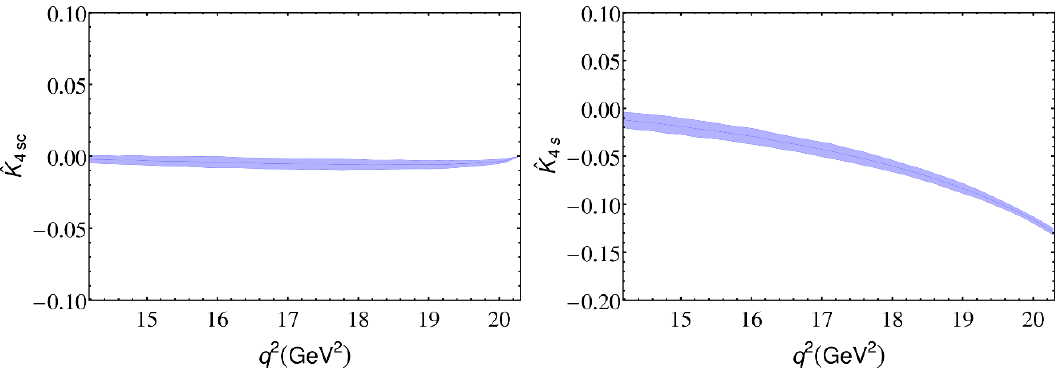
Figure 2 . The SM predictions of ^ K 4 sc and ^ K 4 s for (cid:3) b ! (cid:3)( ! p + (cid:25) (cid:0) ) (cid:28) + (cid:28) (cid:0) as a function of q 2 . The bands correspond to the uncertainties discussed in text. Since the OPE at large q 2 does not capture local resonance structures, the distributions can be locally o(cid:11) from the OPE predictions. From the plot of the di(cid:11)erential branching ratio d B =dq 2 we see that the branching ratio